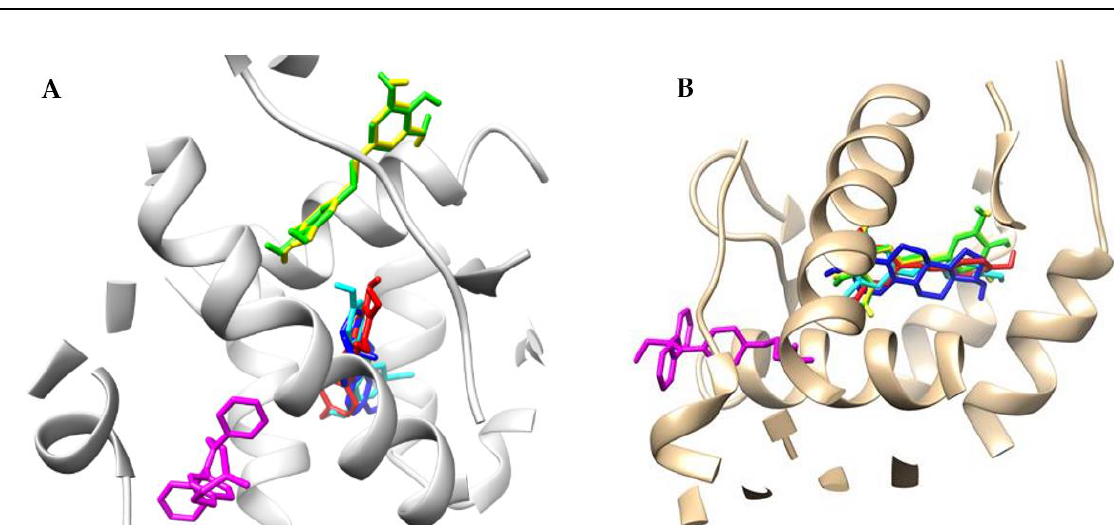
Figure 2. Superimposition of docked ligands: M8 (red), M12 (green), M11 (yellow), resveratrol (cyan), estradiol (blue) and tamoxifen (magenta); first poses (Chimera 1.13.1 package) protein (contacts under d ≤ 9 Å) in estrogen receptor α (A; 3dt3.pdb) and estrogen receptor β (1l2j.pdb). Panel A presents ERα while panel B shows ERβ.